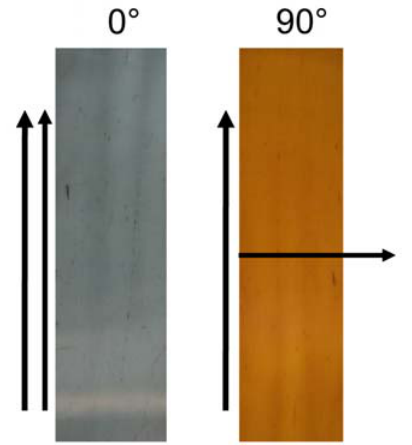
Figure 6. Images of oriented PVA@AgNR film (Dr = 5) observed through a linear polarizer with the transmission axis parallel (0°) and perpendicular (90°) to the drawing